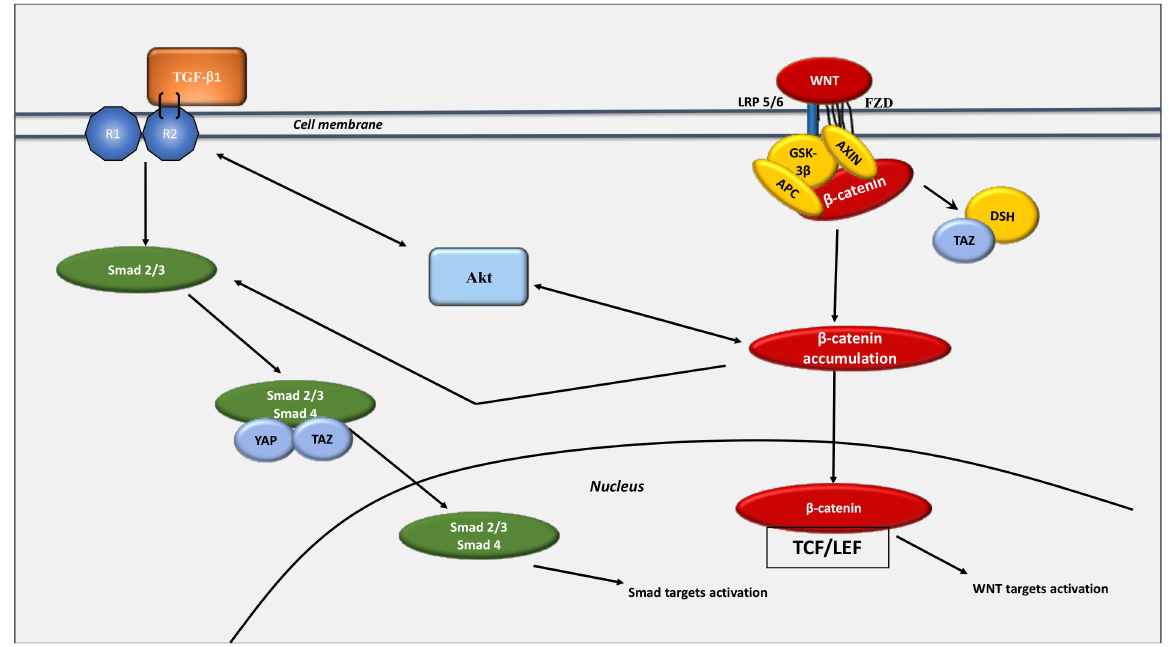
Figure 6. Interaction between the WNT/ β -catenin pathway and the Hippo pathway. Crosstalk between the YAP/TAZ and TGF- β pathways is observed. TAZ interacts with Smad2/Smad3 [285] to induce the nuclear transfer of Smad2/3 and then to transcribe the PAI-1 and Smad target genes. In the cytosol, TAZ is bound to the WNT/ β -catenin signaling by a TAZ/ β - catenin complex [279]. WNT stimulation is associated with the inhibition of the β -catenin destruction complex, resulting in cytosolic β -catenin accumulation and its nuclear translocation for stimulating the different WNT targets. Following WNT activation, TAZ decreases the DSH phosphorylation and liberates it from the destruction complex. The destruction complex is destroyed because YAP and TAZ dissociate from the complex. Following TGF- β 1 stimulation, AXIN leads to the enhancement of the tail-phosphorylation of Smad2/3. The stimulated Smad2/3-Smad4 complex interacts with TAZ and YAP and translocates to the nucleus for the stimulation of the Smad targets. TGF- β 1 leads to Smad2/3 and PI3K/Akt signaling overactivation. The nuclear translocation of β -catenin blocks the degradation of TAZ. This relationship of TAZ with the WNT/ β -catenin pathway is independent of its role as a mediator of the Hippo pathway. When WNT/ β -catenin signaling activity is decreased, the cytoplasmic YAP/TAZ specifically interacts with AXIN [280]. Activation of YAP/TAZ leads to stimulation of glutamine levels, to the enhancement of nucleotide synthesis, and to the promotion of glutamine synthetase (GS) expression